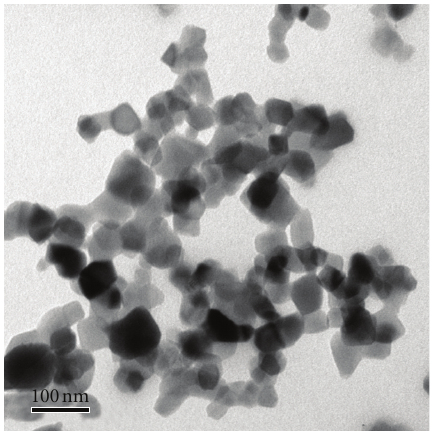
Figure 1: TEM images of TiO 2